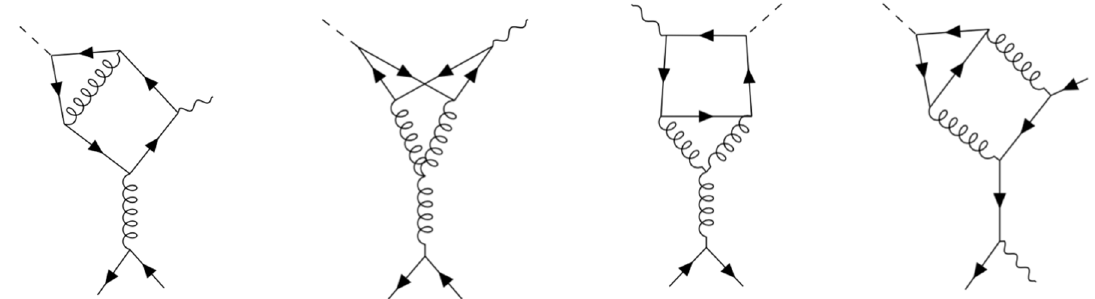
Figure 2 . Examples of diagrams where the Higgs boson or the Higgs and the Z boson are coupled to a closed quark